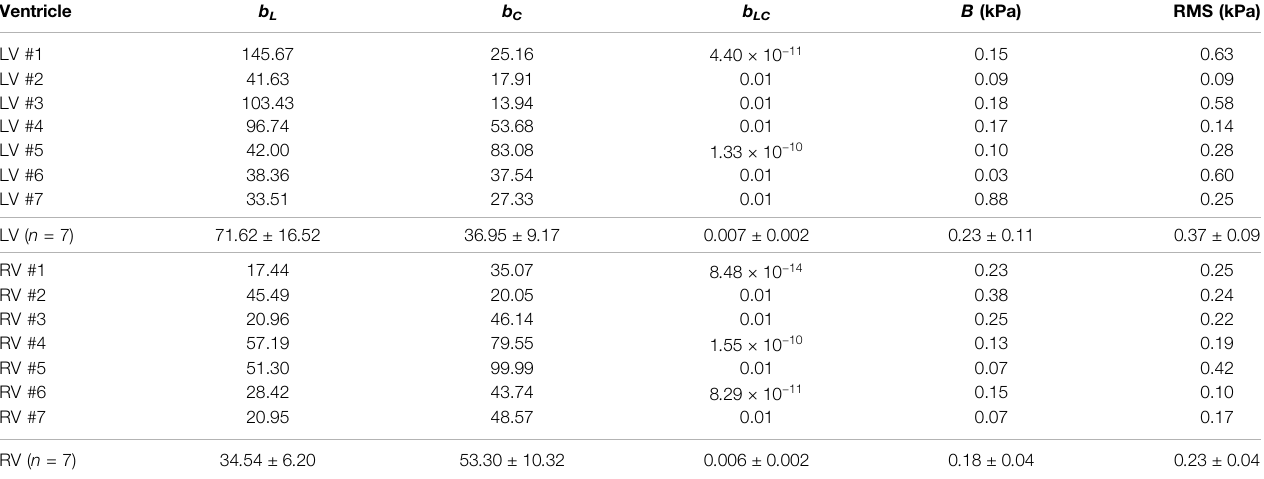
TABLE 2 | Fung model fi tting results. Average data are presented as mean ± SEM. Ventricle